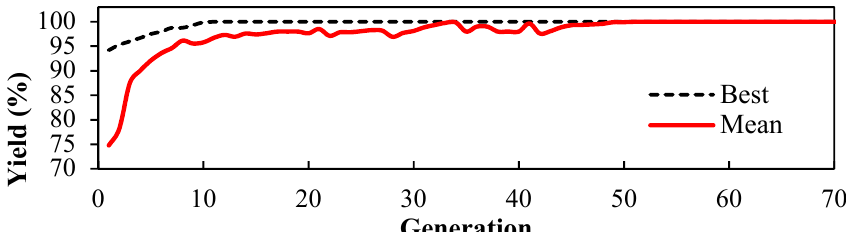
Figure 5. Converging plot of genetic algorithm for optimising preparation conditions of catalysts via sol-gel method using SVM model.